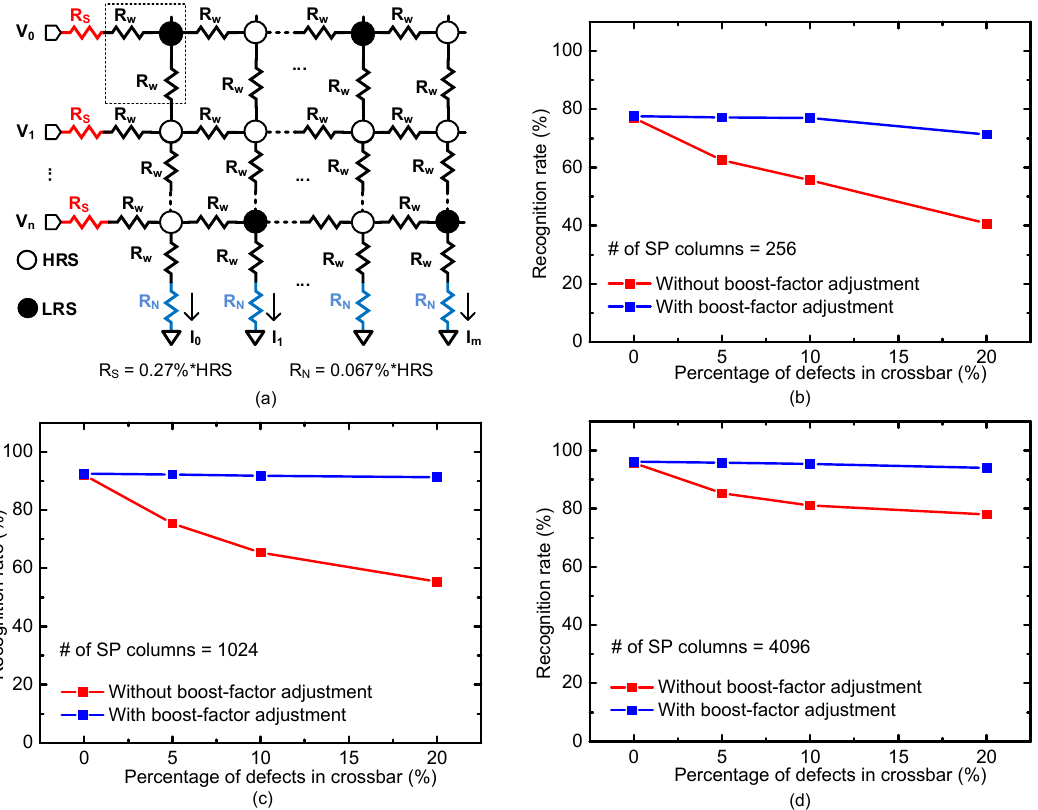
Figure 8. ( a ) The memristor crossbar with the non-ideal effects of R S , R N , and R W . Here R S = 0.27%*HRS and R N = 0.067%*HRS.; ( b ) the MNIST recognition rate of the non-ideal crossbar with 256 SP columns. Here, SP means Spatial Pooler. The percentage σ of memristance variation of HRS and LRS is assumed to be 0% in Figure 8.; ( c ) the MNIST recognition rate of the non-ideal crossbar with 1024 SP columns. Here the percentage σ of memristance variation of HRS and LRS is 0%; and ( d ) the MNIST recognition rate of the non-ideal crossbar with 4096 SP columns. The percentage σ of memristance variation in HRS and LRS is assumed 0%.